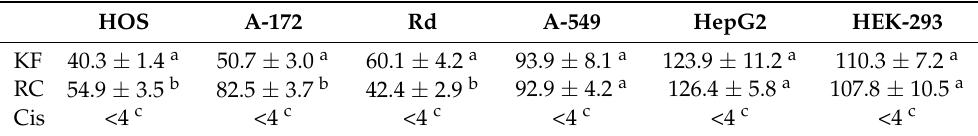
Table 5. Cytotoxicity index (IC 50 ± SE) of plant extracts and cisplatin against human cancer cell lines, µ